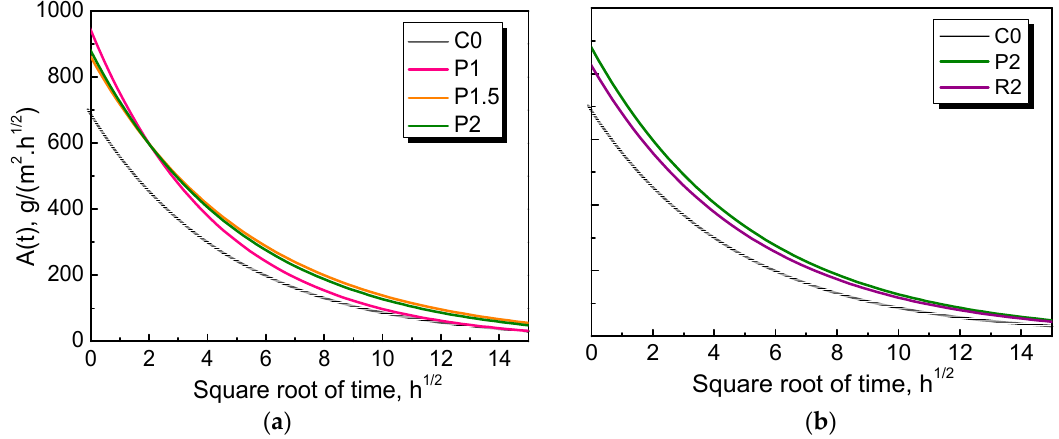
Figure 14. Time-dependent coefficient of capillary absorption of ( a ) PALF reinforced composites and ( b ) comparison of C0, P2 and R2.